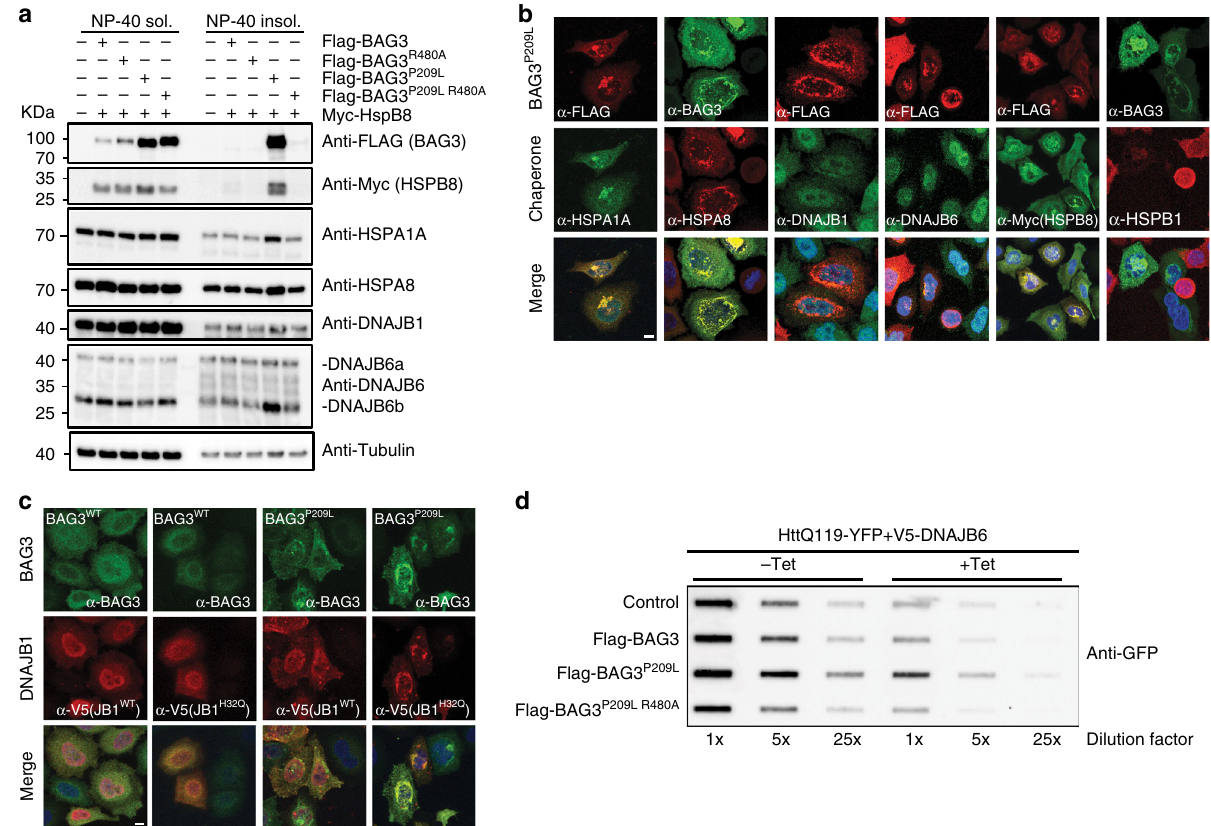
Fig. 7 PQC proteins co-aggregate with BAG3 P209L . a Fractionation of HEK293 cells expressing Myc-HSPB8 and BAG3 variants. Western blots using the indicated antibodies is shown. The same samples as in Fig. 5e have been used, loading control is therefore the same. b Immuno fl uorescence pictures of HeLa cells expressing FLAG-BAG3 P209L . Cells were stained with the indicated antibodies for staining endogenous chaperones except HSPB8 (which was stained using antibodies against myc after expression of myc-HSPB8). Scale bar = 5 μ m. c Immuno fl uorescence pictures of HeLa cells expressing BAG3 WT or BAG3 P209L (upper row in green) with V5-DNAJB1 WT or V5-DNAJB1 H32Q (middle row in red). Lower row depicts the merge with DAPI. Scale bar = 5 μ m. d Filter trap assay of HEK293 cells expressing HttQ119-YFP together with tetracyclin-inducible DNAJB6b and the indicated FLAG-BAG3 variants. Immunoblot using a GFP antibody is shown. Source data are provided as a Source data fi